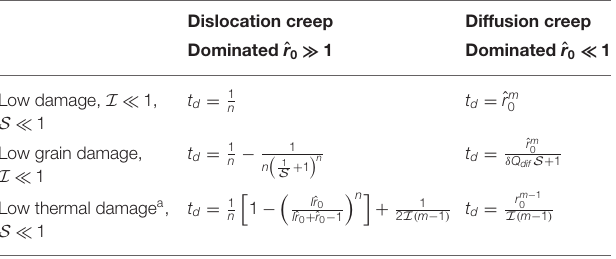
TABLE 3 | Summary of analytical detachment time predictions for different